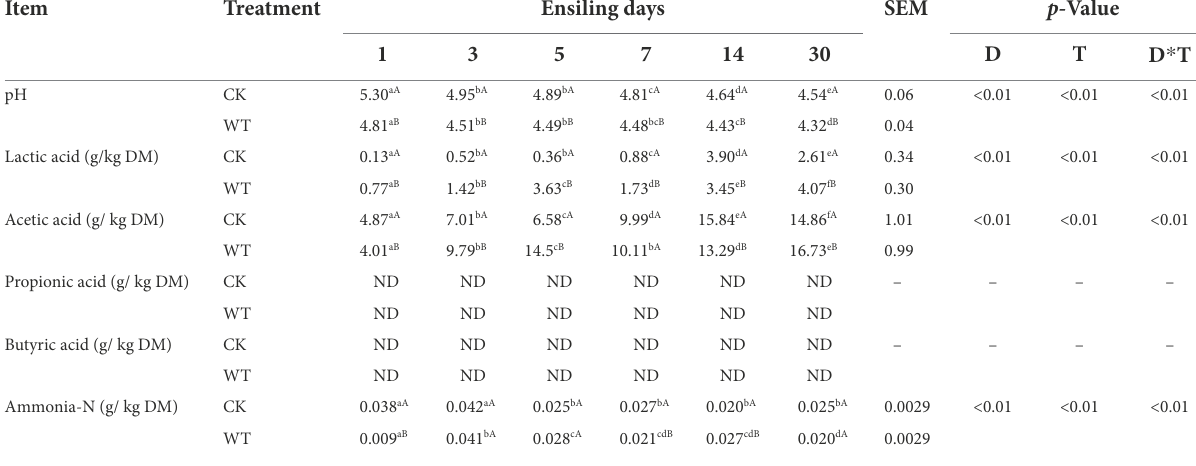
TABLE 1 Fermentation characteristics of king grass silage during silage.